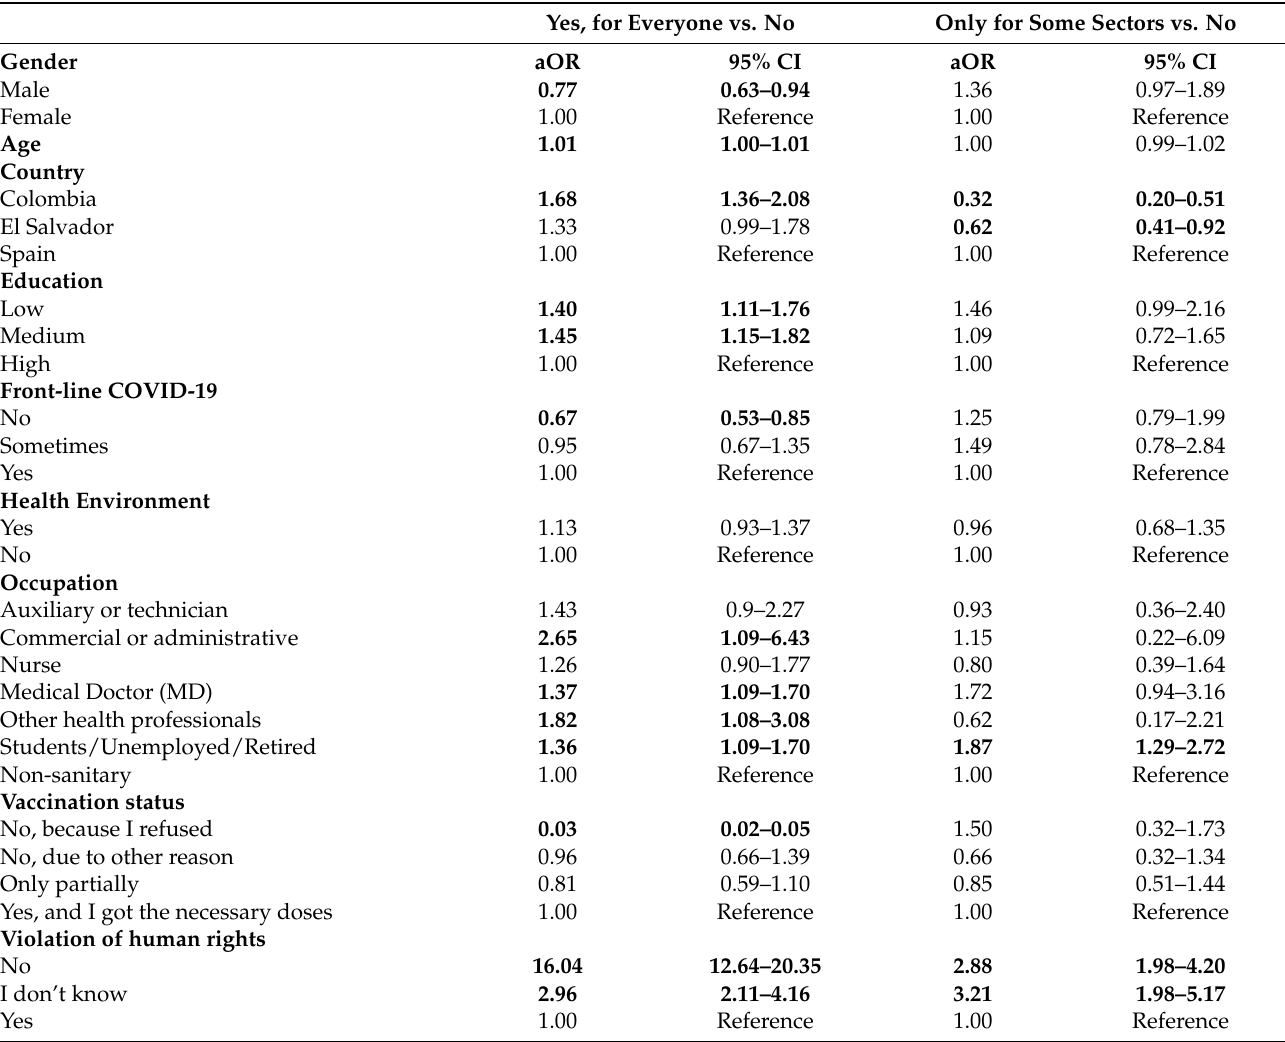
Table 3. Predictor factors about the acceptance of making COVID-19 vaccination mandatory (refer- ence: no). Results from Multinomial Logistic Regression